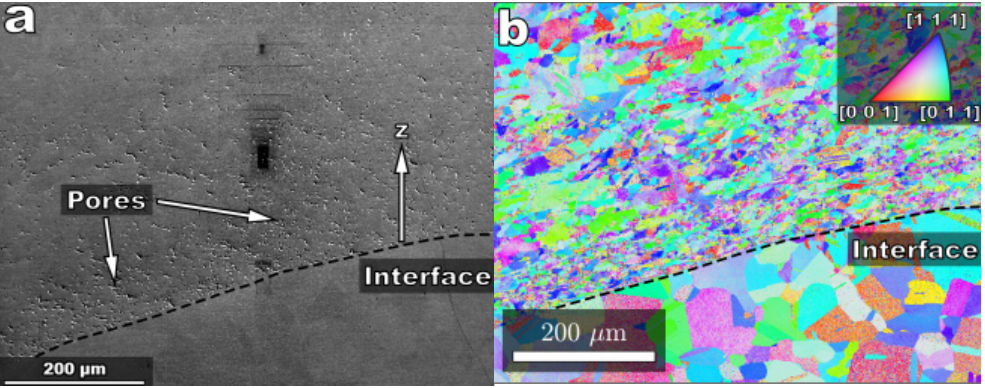
Figure 10. The SEM result of the substrate–deposit interface. ( a ) Fine porosity at the interface. ( b ) The inverse pole figure map of the interface.